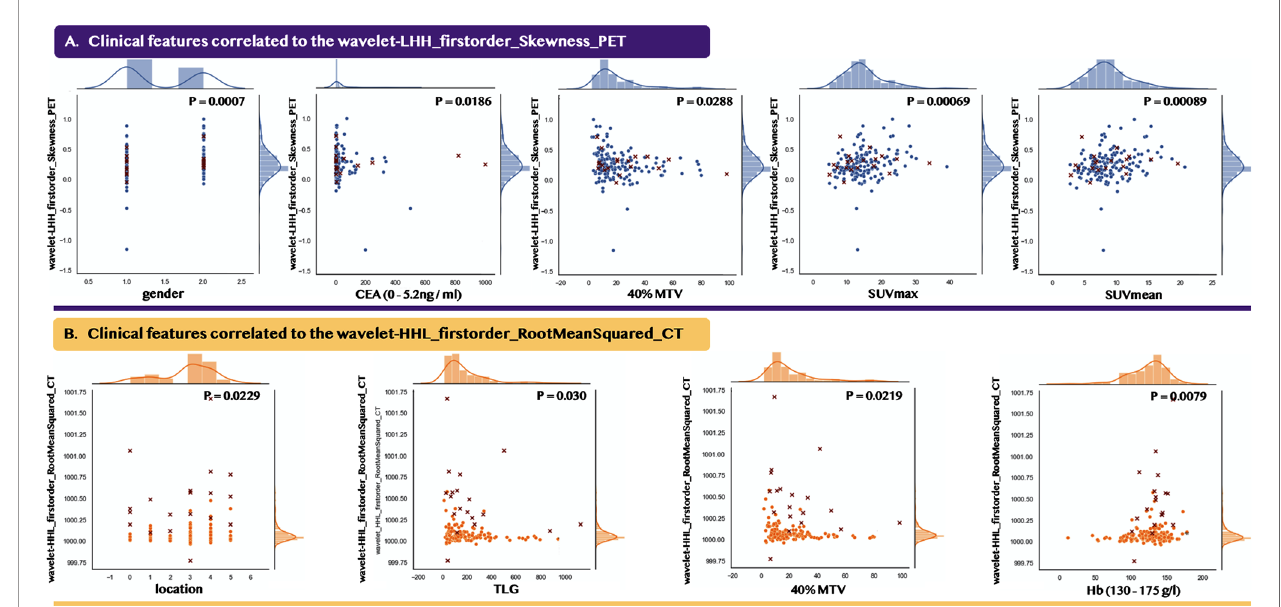
FIGURE 6 | Data distribution between the selected radiomic features and their statistically correlated clinical features. Point mark and cross mark indicate the patients from the 2010 – 2018 and 2018 – 2020 periods, respectively. (A) indicates the PET feature, while (B) indicates the CT feature. For gender and location, we applied the Point-Biserial correlation method, while for the other clinical features, we applied the Pearson correlation